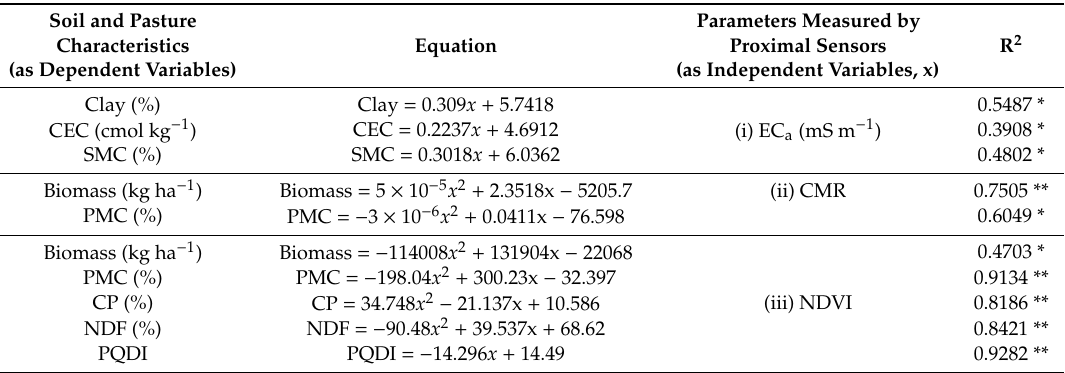
Table 7. Best significant relationships between soil, pasture, and sensors parameters: (i) Relationships between soil apparent electrical conductivity (EC a ) measured by Dualem sensor and soil parameters; (ii) relationships between corrected meter readings (CMR) measured by Grassmaster II probe and pasture parameters; (iii) relationships between normalized di ff erence vegetation index (NDVI) measured by OptRx sensor and pasture